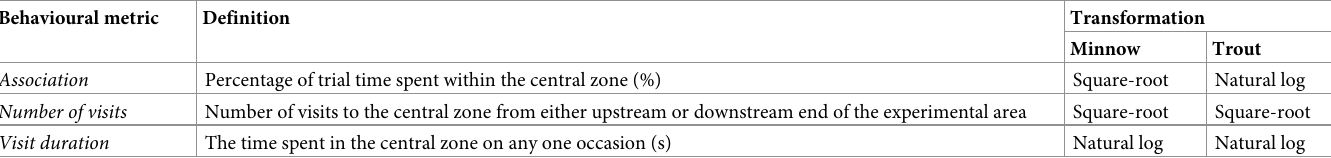
Table 2. Definitions of the behavioural metrics devised to statistically analyse fish behaviour during each